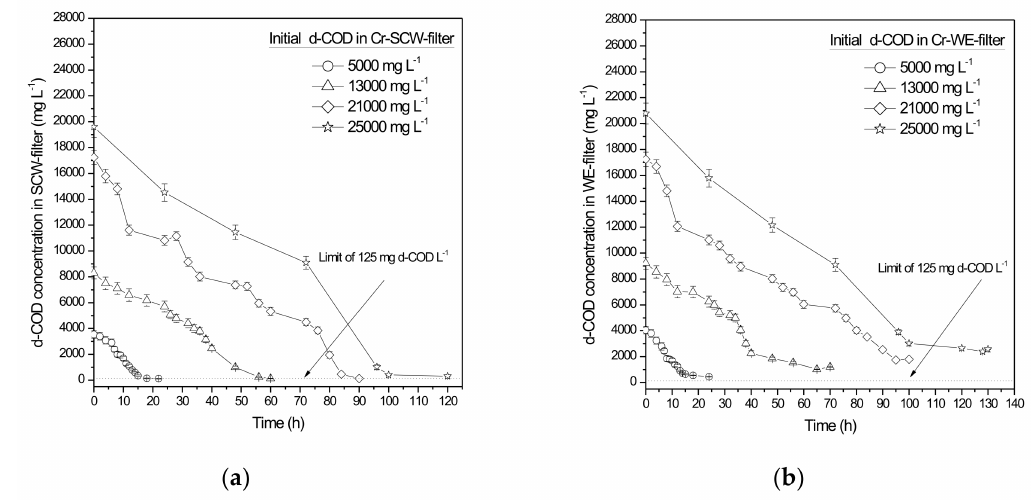
Figure 8. Percentage removal of d-COD in the: ( a ) SCW-filter or ( b ) WE-filter for various initial d-COD concentrations (depending on the effluent of the Cr-SCE-filter or Cr-WE-filter,